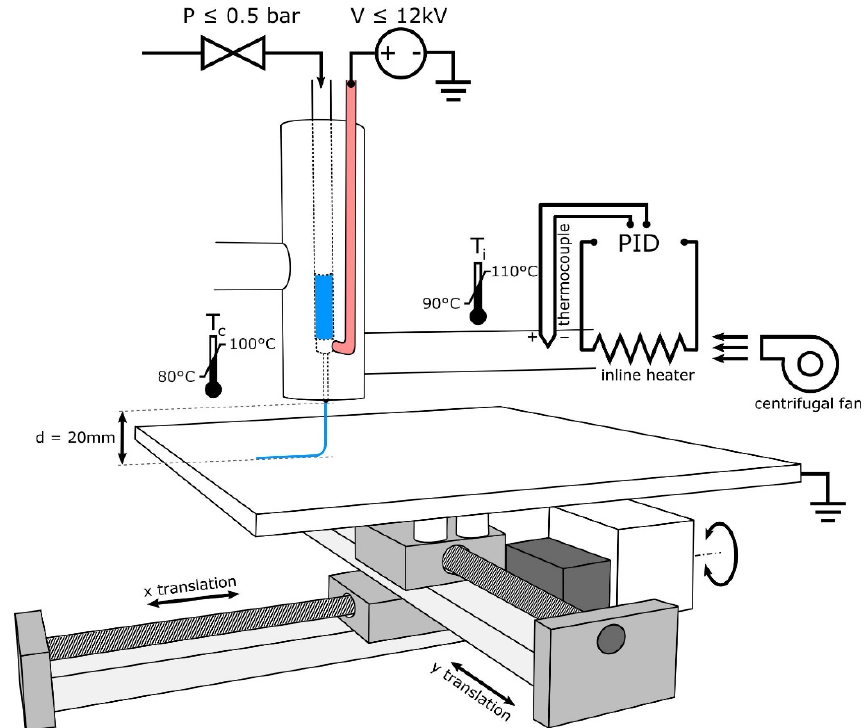
Figure 1. Schematic of MEW device design illustrating the use of heated air to control syringe and needle temperature while using air pressure and high voltage to draw PCL and to produce electrospun fibers [21]. Copyright 2018 Elsevier.